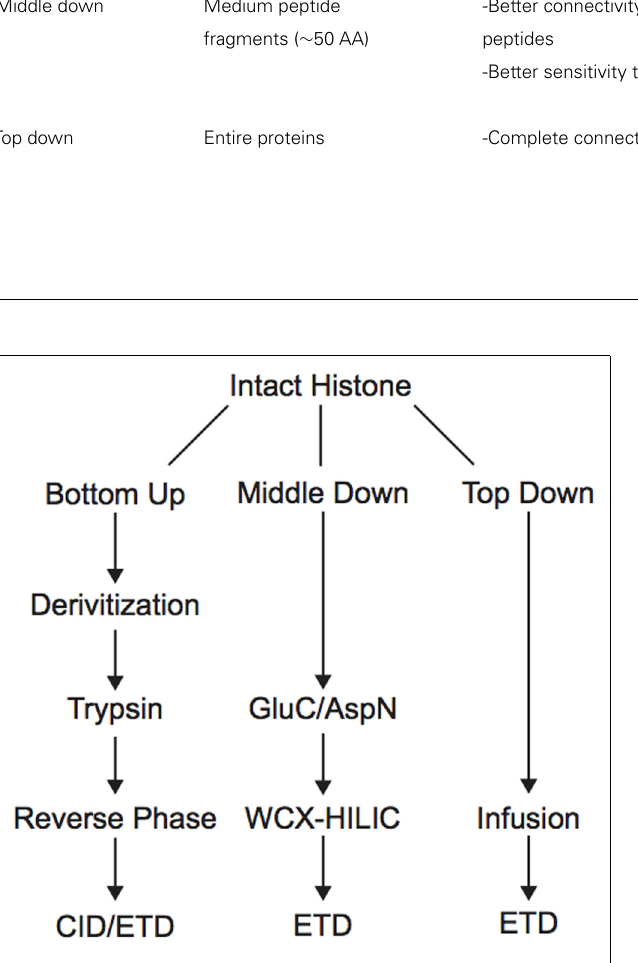
FIGURE 1 |Workflow for bottom-up, middle-down, and top-down mass spectrometry